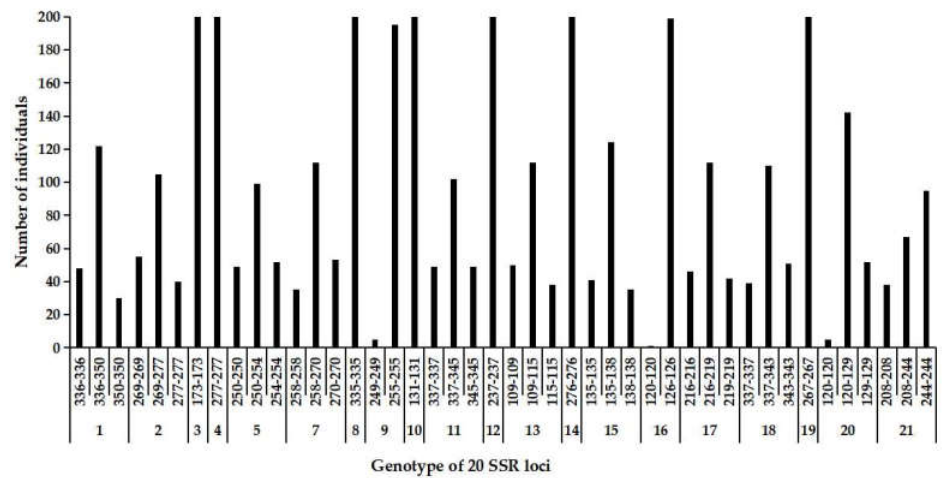
Figure 6. The frequency of genotype across the 20 SSR loci in the self-pollinated offspring. Individual number of a certain genotype was shown in the Y-axis and genotype of SSR loci was show in the X-axis.